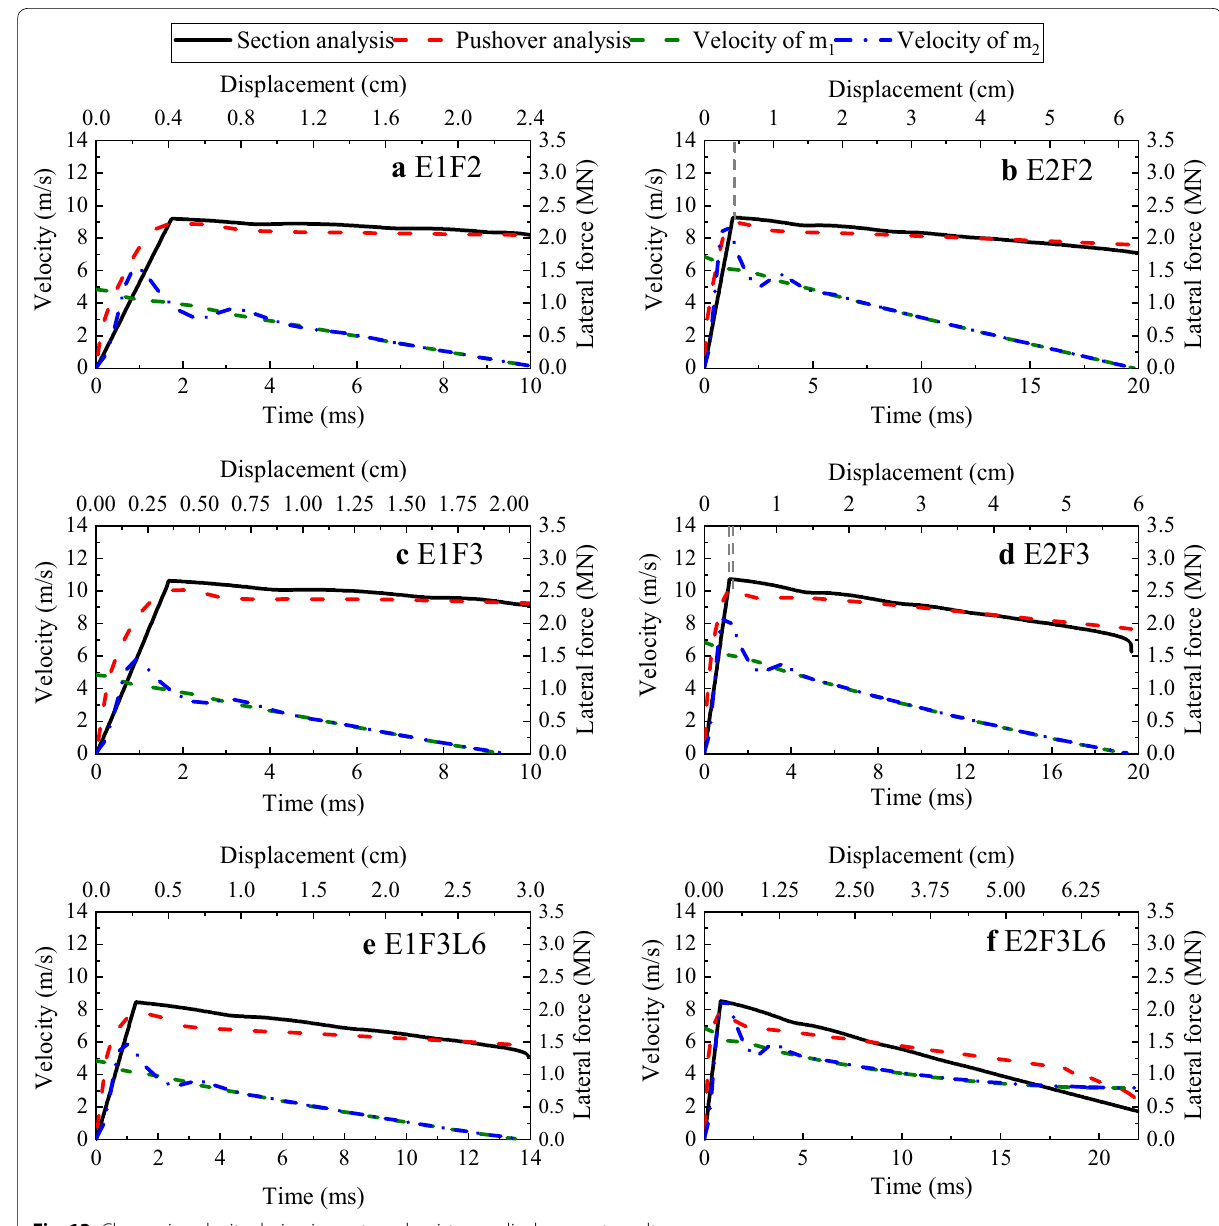
Fig. 13 Change in velocity during impacts and resistance-displacement